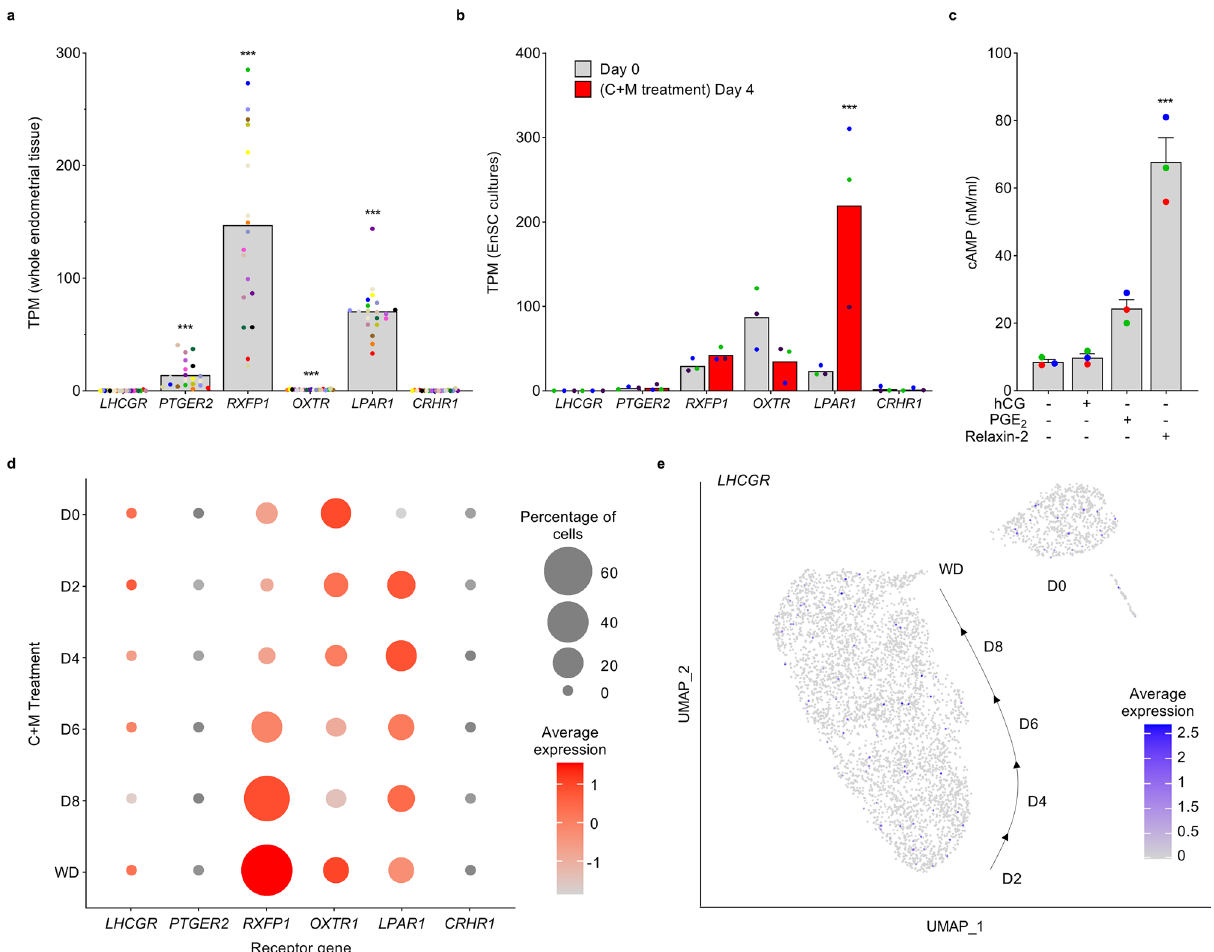
Figure 1. LHCGR expression in whole endometrial biopsies and EnSC. ( a ) Expression of genes coding GPCRs within whole endometrial biopsies (GEO GSE65102). Data points from individual patients are colour matched and shown together with bar graphs denoting mean (n = 20). Significance was determined by ANOVA and Dunnett’s multiple comparison test using LHCGR as the comparator. *** P < 0.001. ( b ) Expression of GPCRs in undifferentiated EnSC (day 0) and cells decidualized with 8-br-cAMP and MPA (C + M) for 4 days (GEO GSE104721). Individual data points from 3 biological replicates are shown with bar graphs denoting mean. Significance was determined by two-way ANOVA and Sidak’s multiple comparison test, *** P < 0.001. ( c ) cAMP responses in EnSC following stimulation with hCG, PGE 2 and Relaxin-2. Significance was determined by ANOVA and Dunnett’s multiple comparison test using LHCGR as the comparator, *** P < 0.001. ( d ) Dot-plot to visualize scRNA-seq data (GEO GSE127918) showing the percentage of EnSC expressing GPCRs, and the Log 2 - transformed average expression within these cells. ( e ) UMAP (uniform manifold approximation and projection) plot of LHCGR expression within scRNA-seq data from undifferentiated (D0) EnSC and those treated with C + M for time points indicated (D = days) before withdrawal (WD). Transcriptomic profiling to identify cell states is shown in Supplementary Fig.